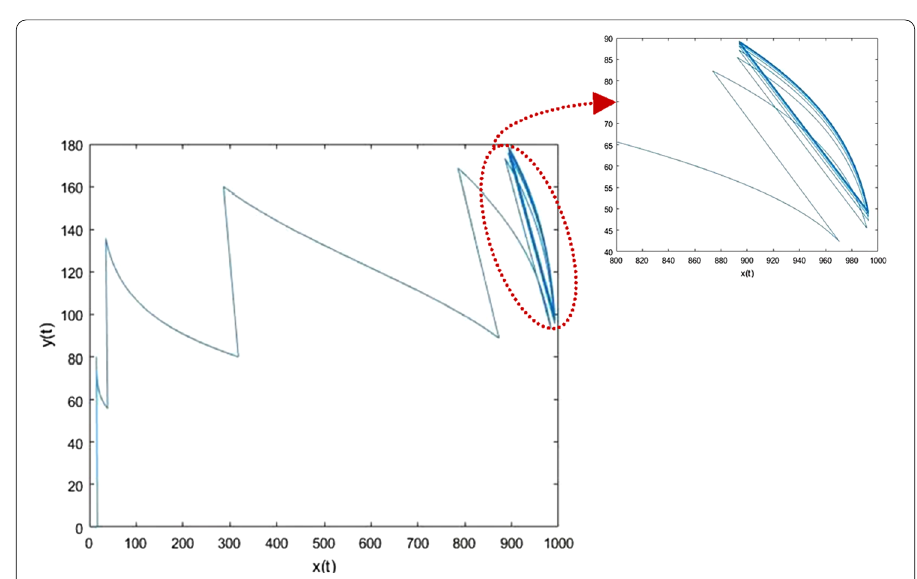
Figure 3 Phase portrait ( T -periodic solution) of the spreader and the disseminator population of system